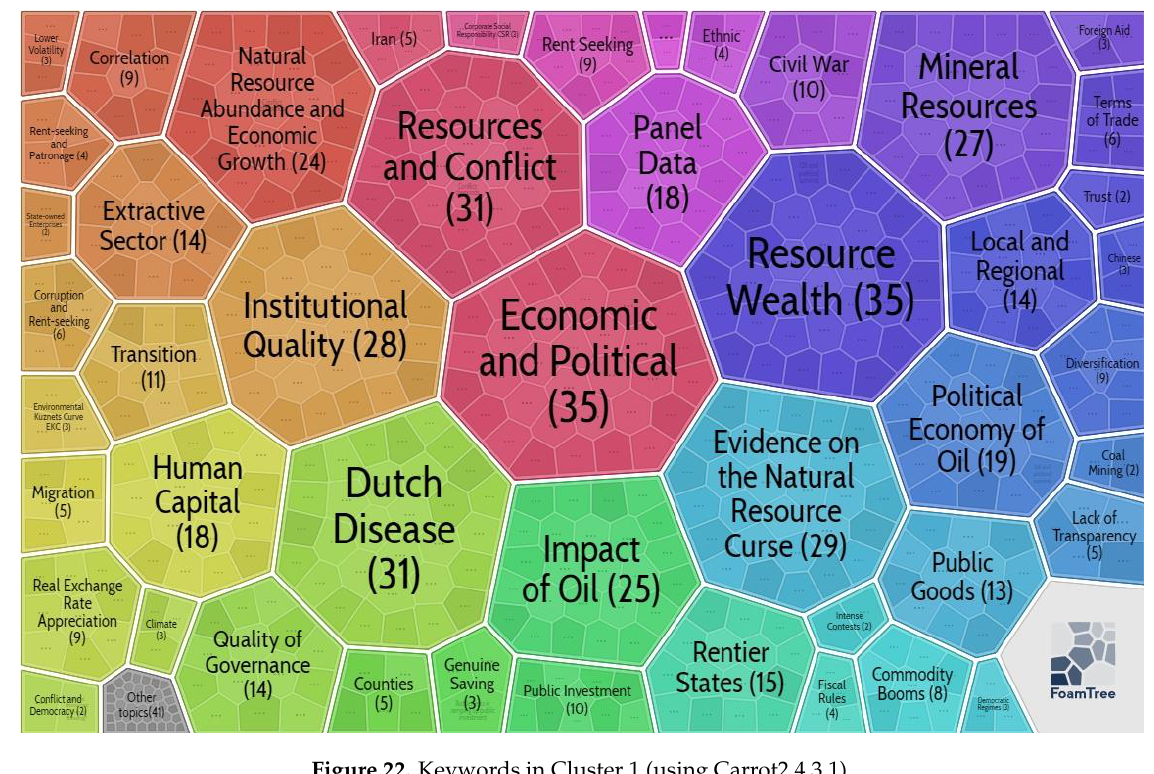
Figure 22. Keywords in Cluster 1 (using Carrot2 4.3.1).